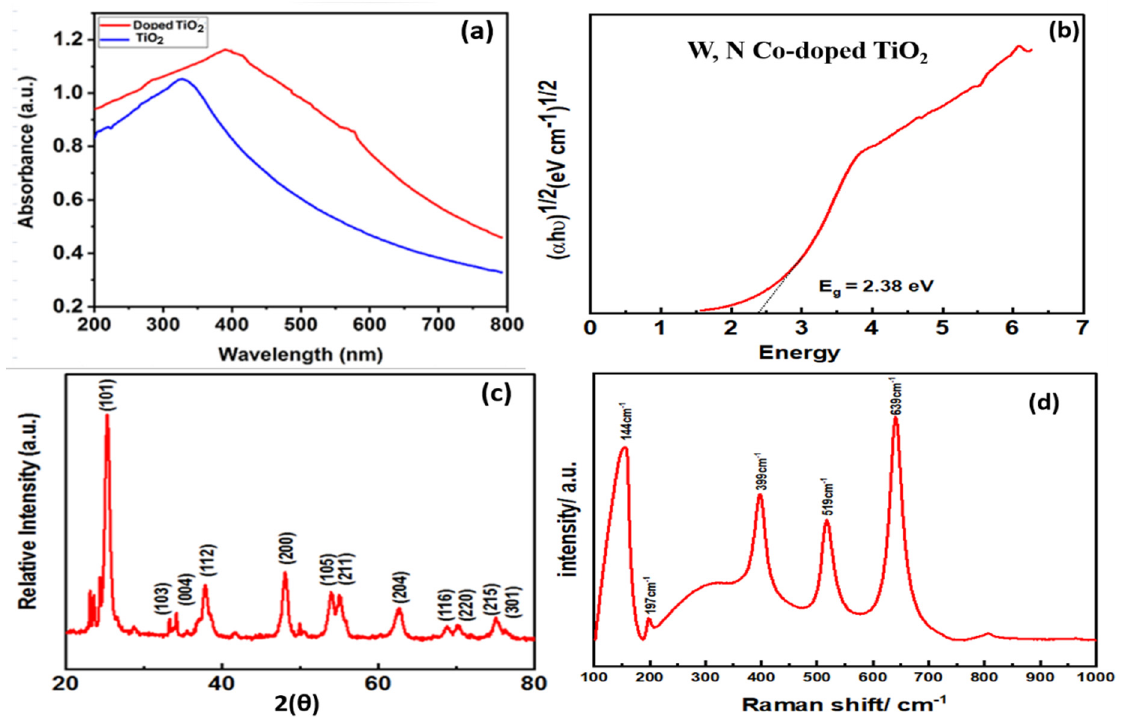
Figure 3. ( a ) UV-vis absorbance spectra of pristine and co-doped TiO 2 Nanoparticles; ( b ) energy band gap of W, N co-doped titania; ( c ) XRD patterns of co-doped titania; ( d ) Raman scattering studies of co-doped titania.